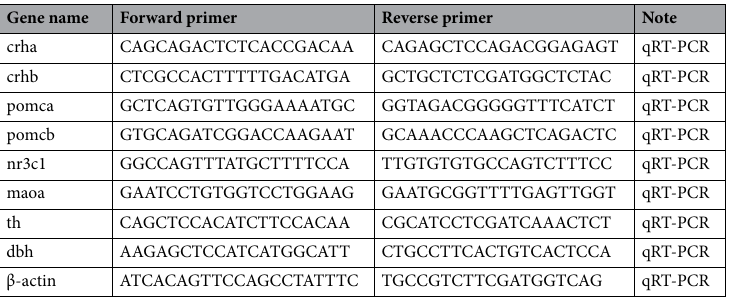
Table 1. The relative primers of